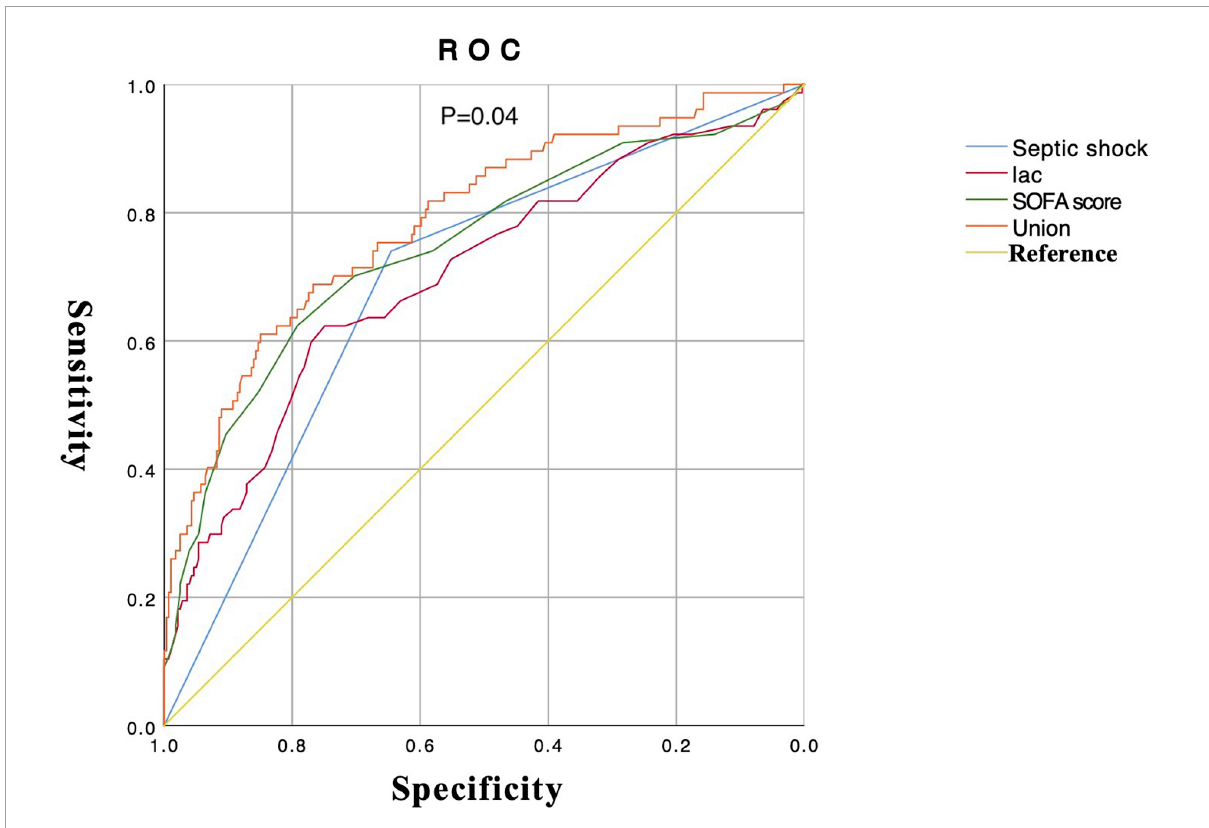
FIGURE4 Drawing of multivariable ROC curve.